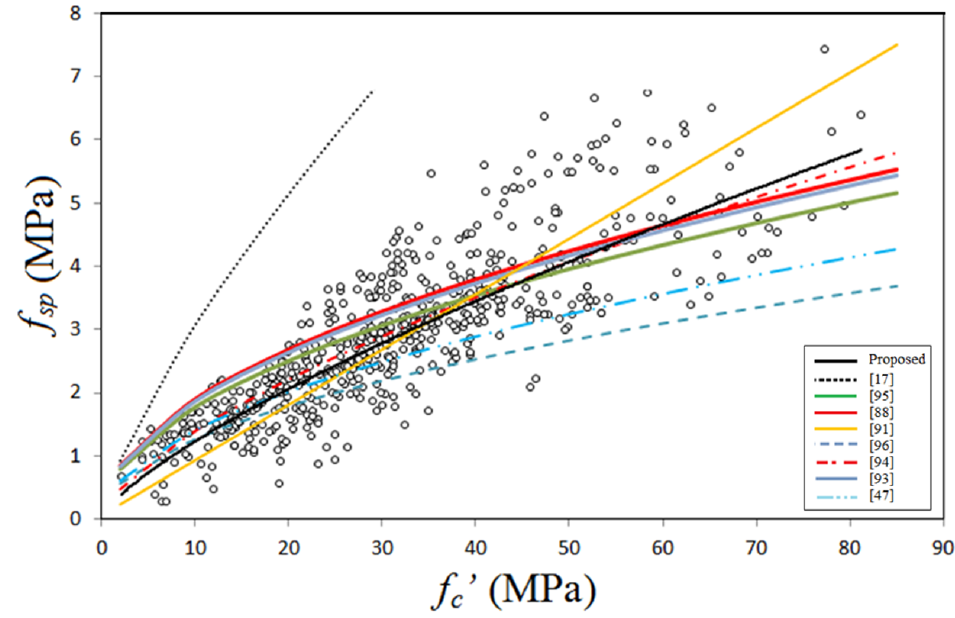
Figure 7. Splitting tensile strength data scatter and proposed equations.